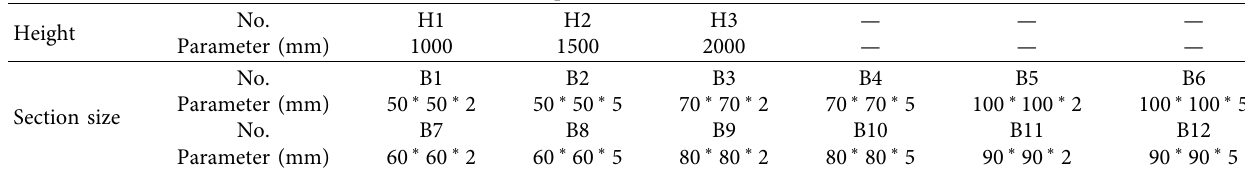
Figure 8: Comparison of experimental results and numerical analysis results of post 3 ((a) load-displacement; (b) load-strain). Table 5: Size parameters of element